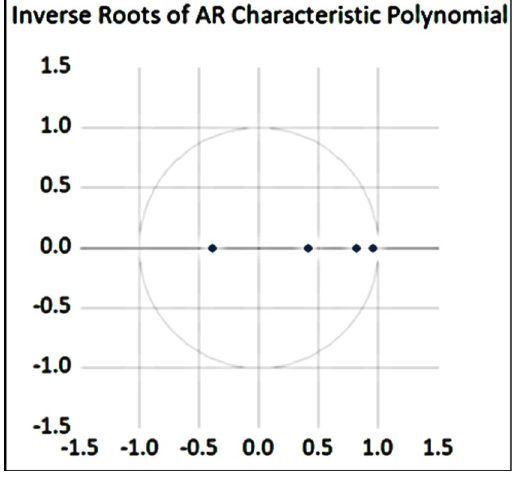
Fig 5. AR root test